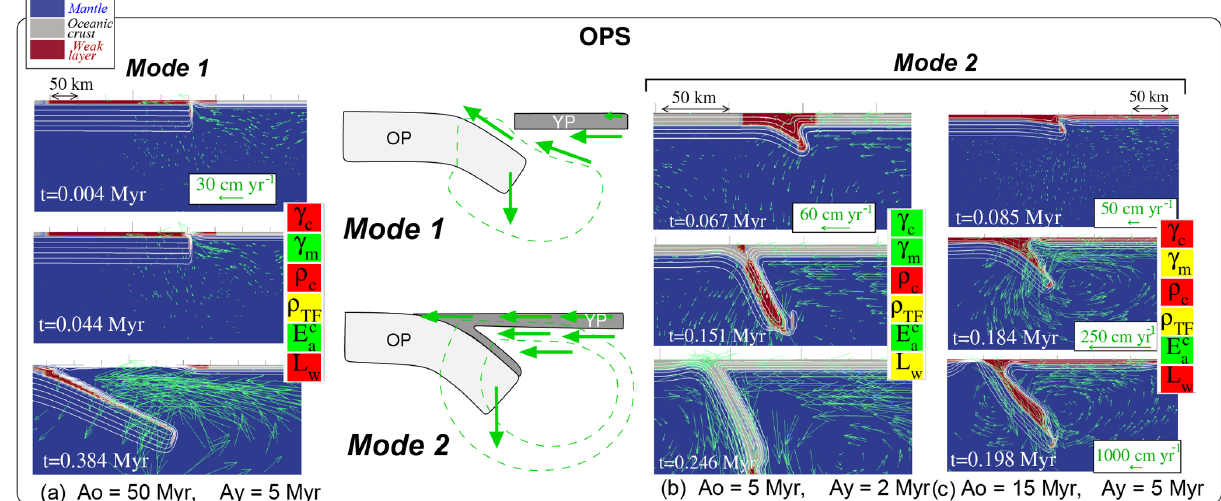
Figure 5. Illustration of OPS: mode 1 in simulation S27c (panel a ) vs. mode 2 in simulations S14i (panel b ), and S22j (panel c ). No vertical exaggeration. The parameter boxes are color coded as a function of the investigated ranges depicted in Fig. 3. Note that the velocity scale in panel (c) is specific for each snapshot. The dashed lines in the middle sketch are a schematic outline of the stream function, and the green arrows illustrate